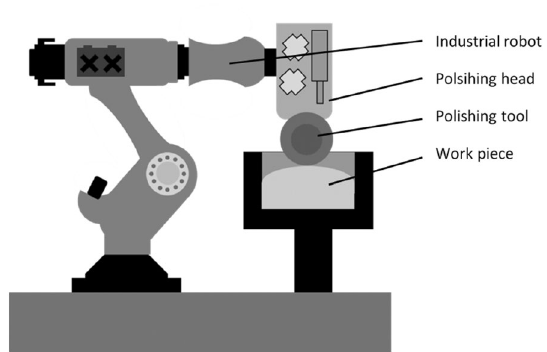
Fig. 1 Schematic illustration of the robot polishing